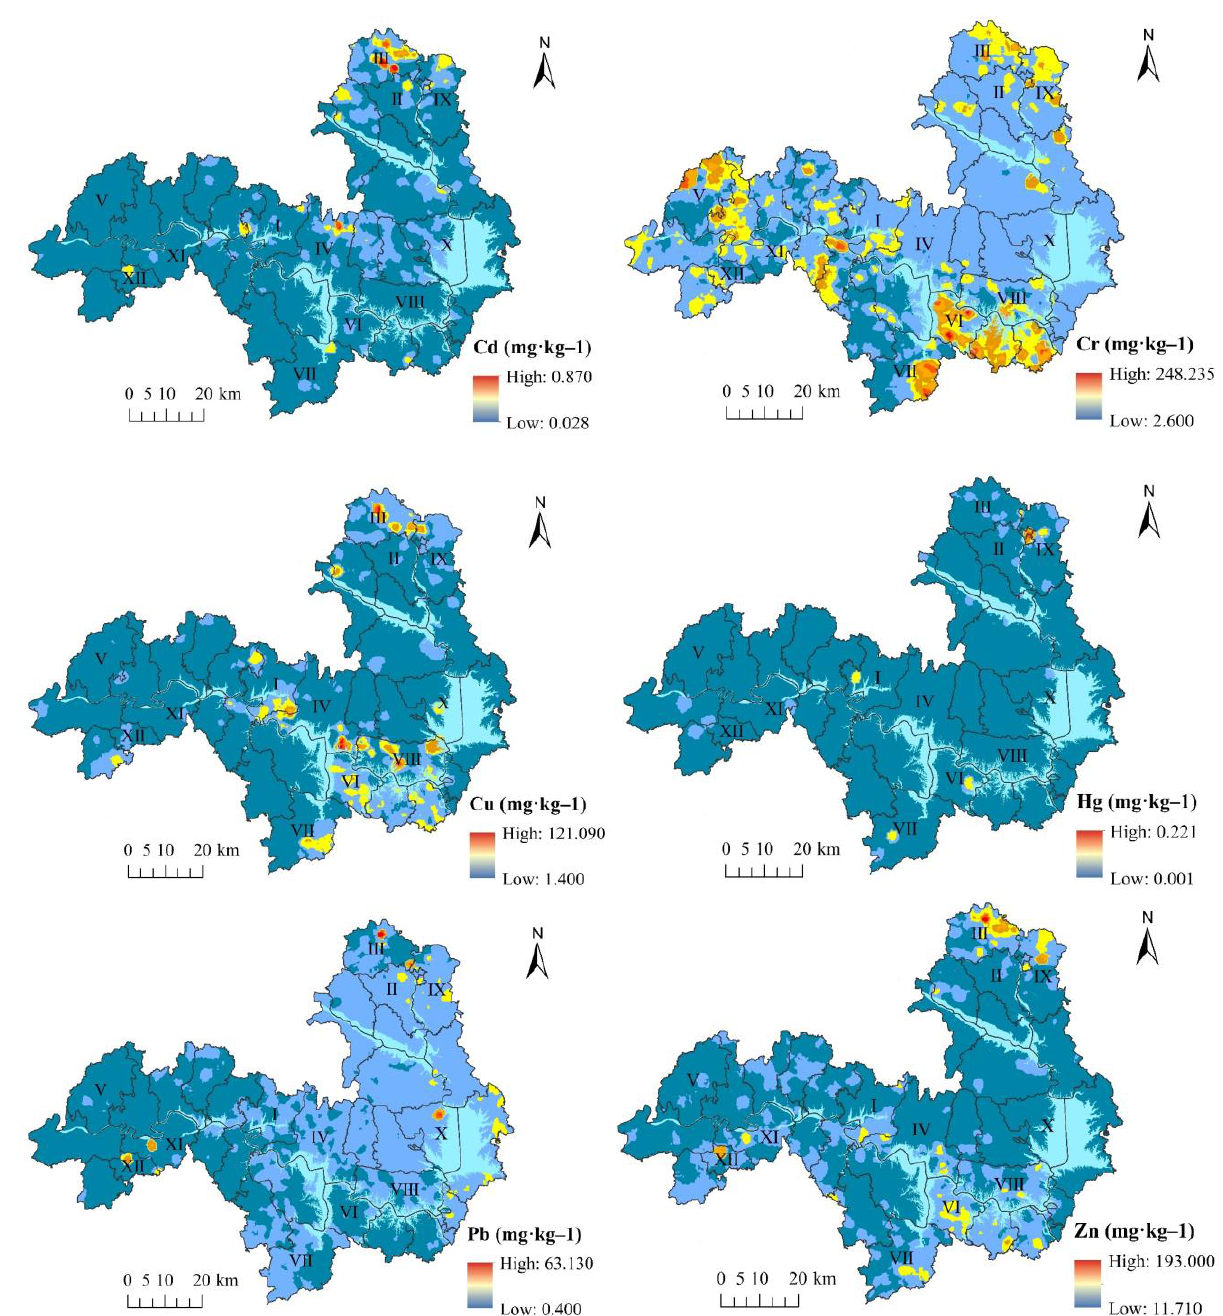
Figure 4. Spatial distribution of heavy metal concentration in topsoil across study area. I: Anyang Town; II: Jinhe Town; III: Maotang Town; IV: Xijiadian Town; V: Hejia Town; VI: Longshan Town; VII: Wudang Mountains, D.C.; VIII: Liangshuihe Town; IX: Shangji Town; X: Cangfang Town; XI: Liubei Town; XII: Fangtan Town.